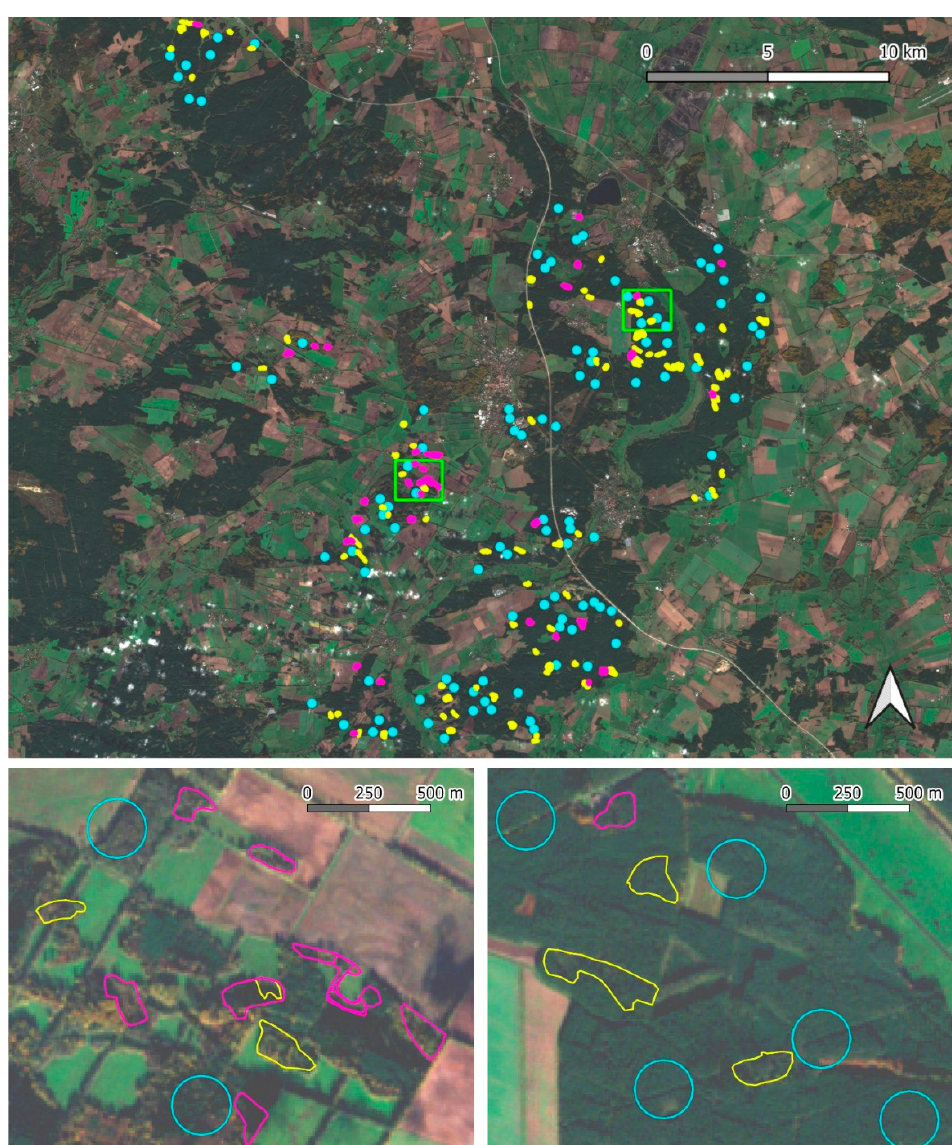
Figure A1. Detailed overview of the study area (main panel), with two exemplary subsections shown in close-up (panels a-b; below). Polygons are differentiated by very low (DG0; yellow) and significant (DG1; magenta) disturbance intensities, besides the randomly selected reference polygons (NDG; blue). The Sentinel-2 RGB image is centered to the municipality of Ludwigslust (Mecklenburg-Vorpommern, Germany), acquired on 06 November 2017. Table A1. Detailed description of the reference (ref1, ref2) and the best-ranked S2 variable-based (log1, log2) logistic regression fits, including regression coefficients, their standard errors, z -, and p - values associated with each predictor. Regressions ref1 and log1 refer to disturbance occurrence (NDG vs. DG0-1), while ref2 and log2 refer to binary disturbance severity (DG0 vs. DG1); β 0 refers to the constant term of the regression (intercept).